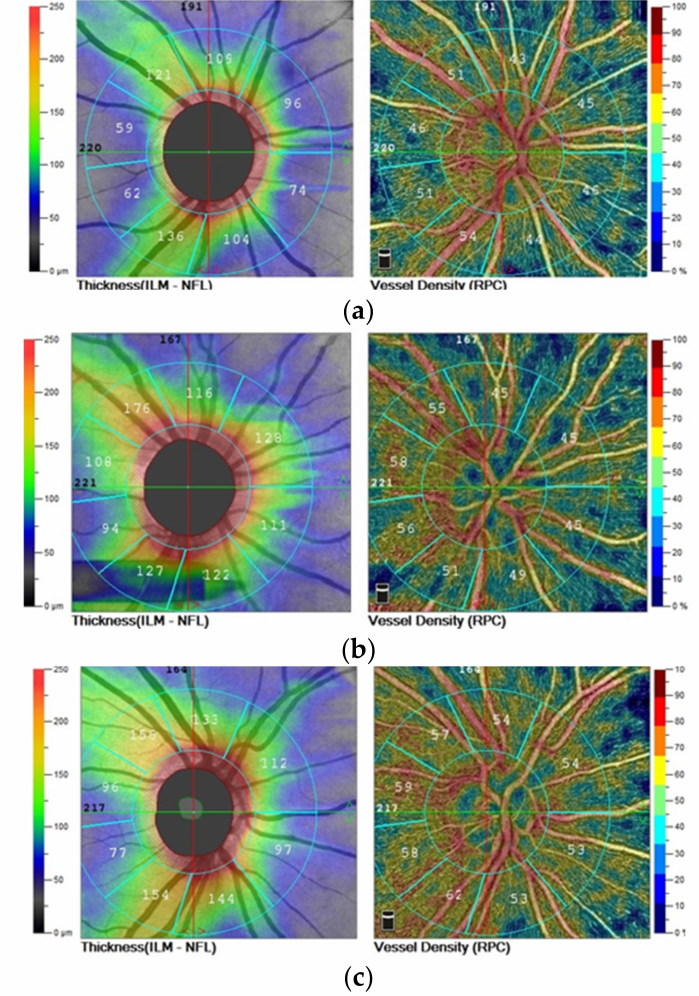
Figure 1. OCTA of nerve fiber layer thickness and the radial peripapillary capillary density in the right eye of patient with ( a ) schizophrenia, ( b ) bipolar disorder, ( c ) control